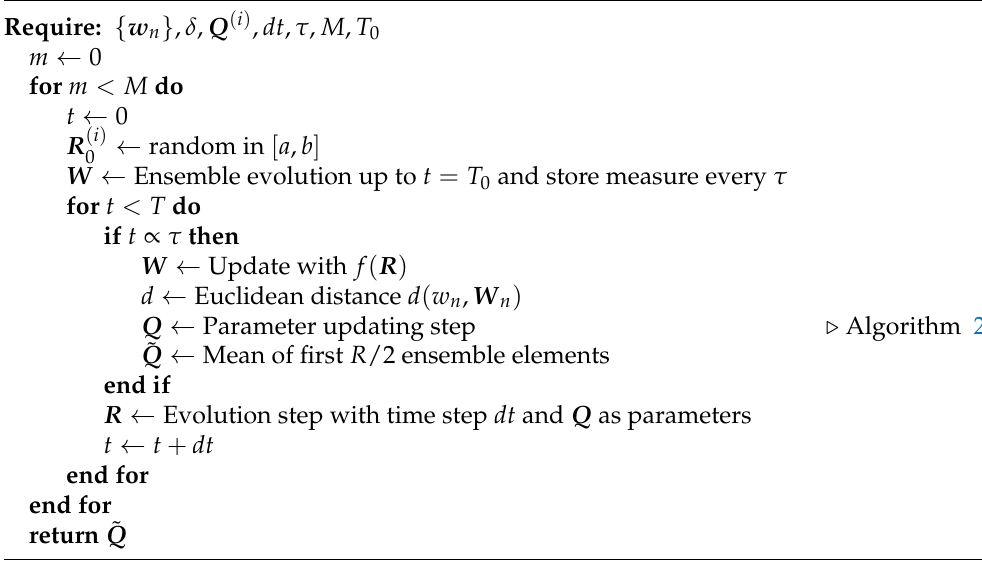
Algorithm 1 Pruned-enriching